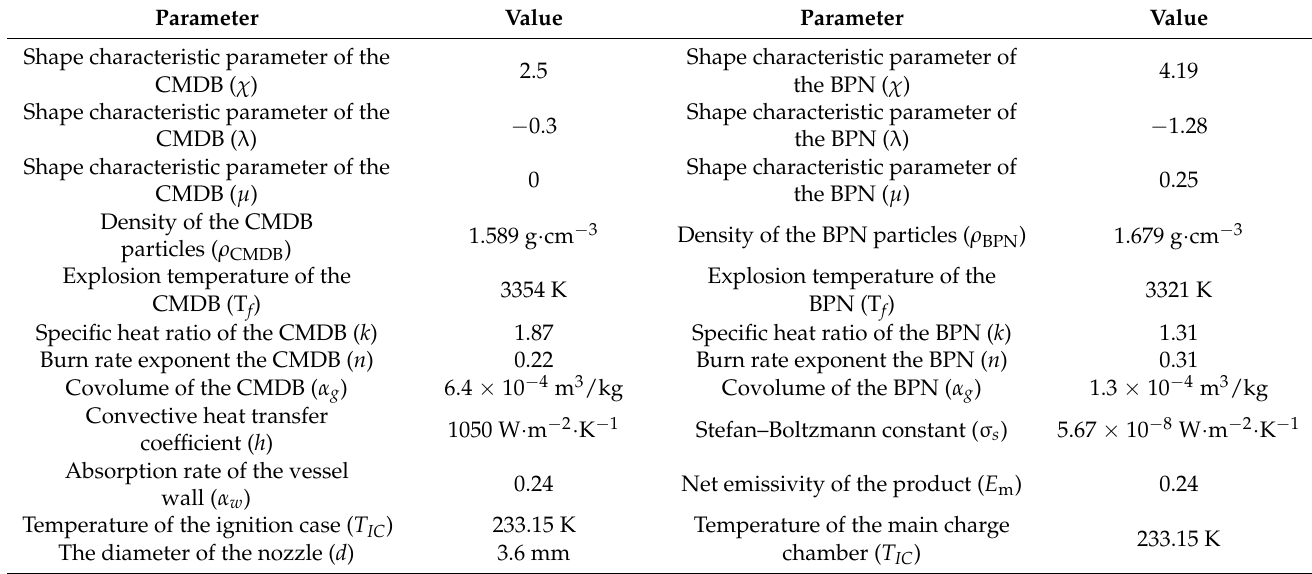
Table 1. Parameters for the analytical combustion model.